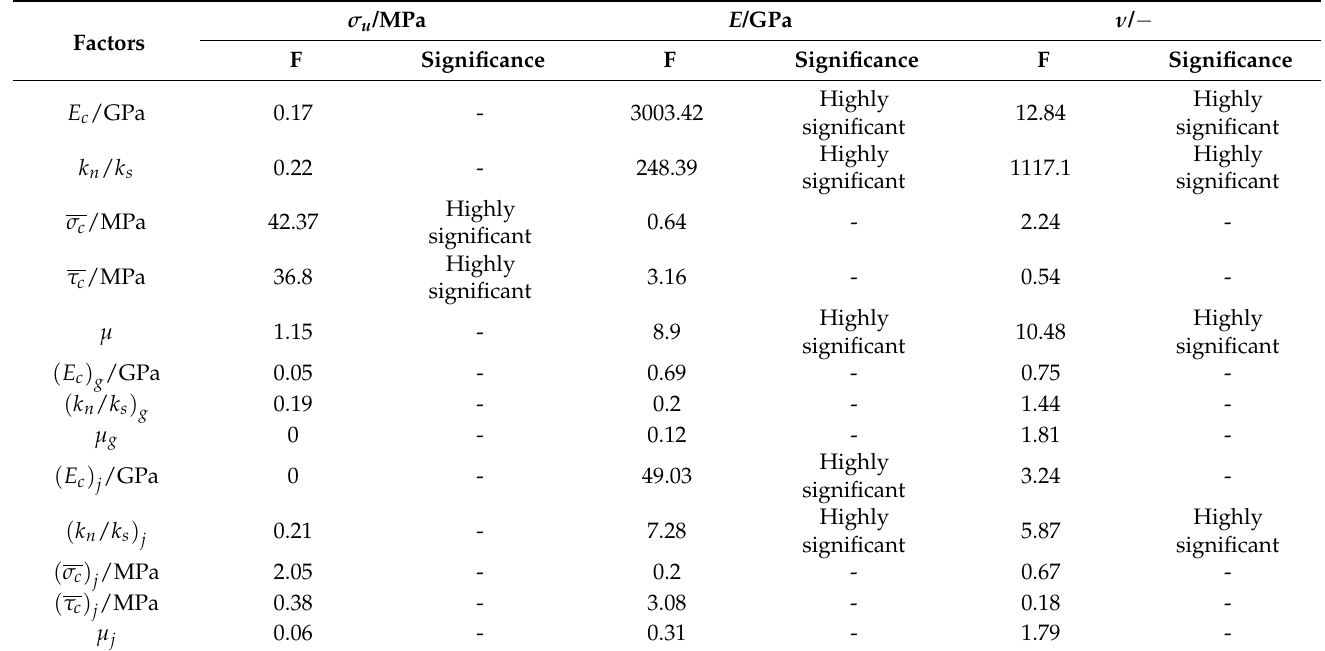
Table 7. Results of analysis of